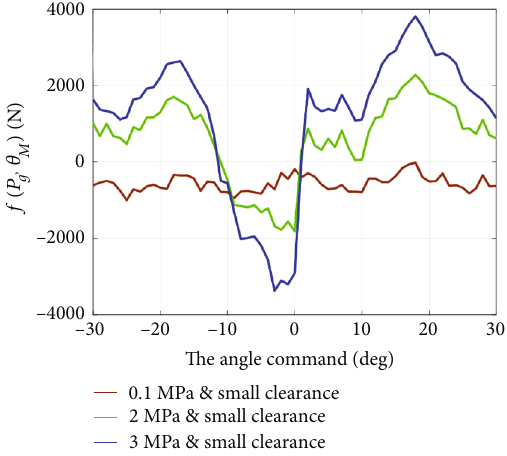
, θ Þ at di ff erent angles. c M